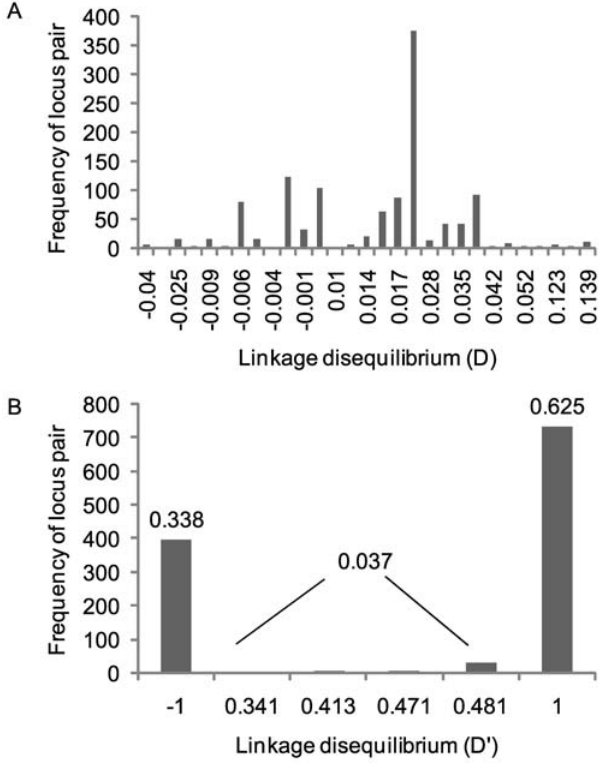
Figure 8. Linkage disequilibrium among study loci. A). The distribution of the linkage disequilibrium coefficient (D) for 1,176 pairwise comparisons of alleles at 54 sSNP and intergenic SNP loci. A total of 751 (64%) of these comparisons are significant by a chi-squared test, and600 (51%) remained significant using a Bonferroni correction for multiple tests. B). The distribution of the standardized coefficient of linkage disequilibrium (D’). Ninety-six percent of the locus pairs are in complete linkage